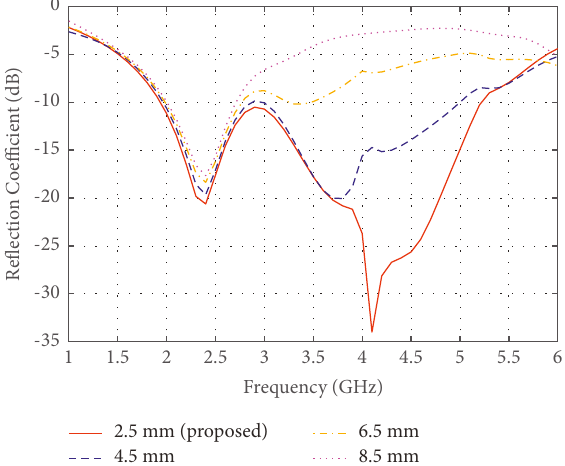
Figure 8: Variation of return loss versus frequency at different values of w 6